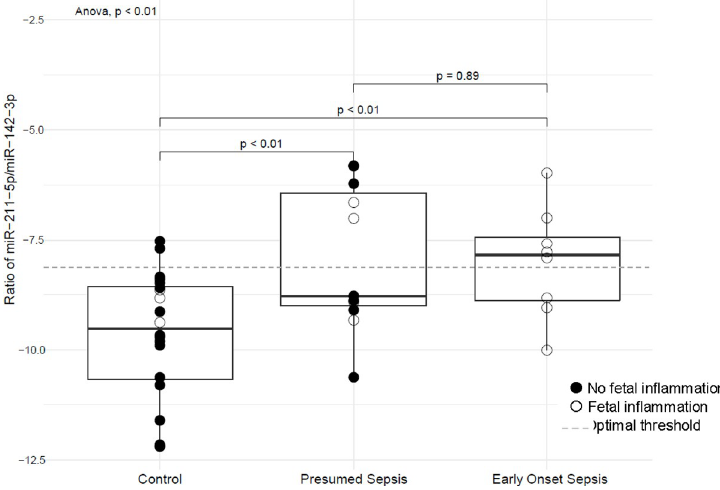
Fig 1. Ratio of miR-211-5p/miR-142-3p in umbilical cord blood plasma. This graph depicts the median, interquartile range, and outliers for the three study groups: non-infected controls, presumed sepsis, and EOS. The ratio is significantly higher in EOS than non-infected controls and presumed